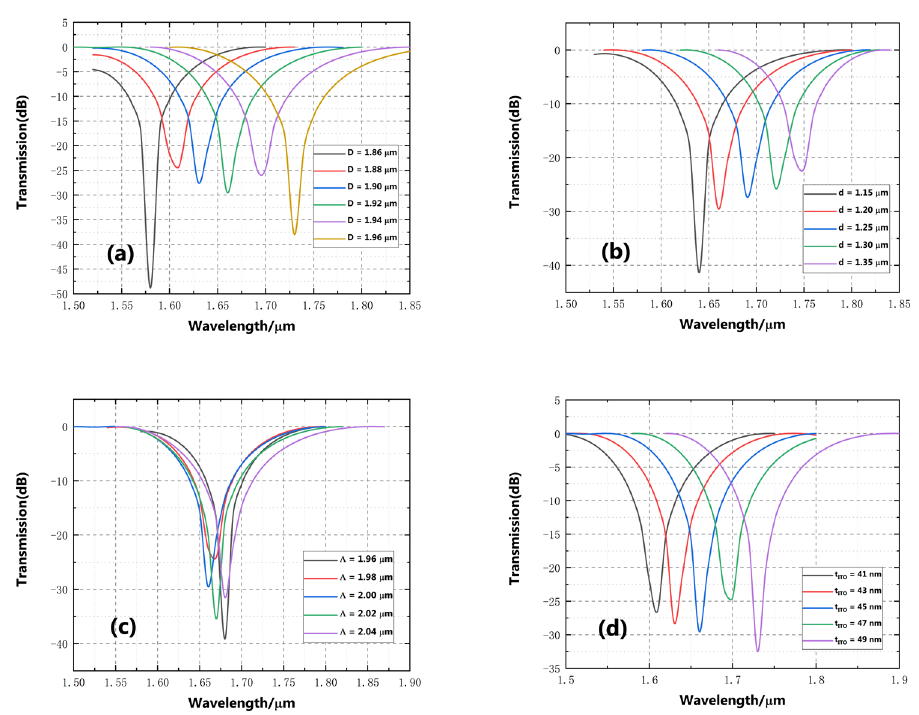
Figure 6. The effects of D , d , Λ , and t ITO on the transmission spectra, H = 0 mT and T = 10 ◦ C. ( a ) The diameter of large pores D . ( b ) The diameter of small pores d . ( c ) The distance between the adjacent pores Λ . ( d ) The thickness of ITO t ITO .